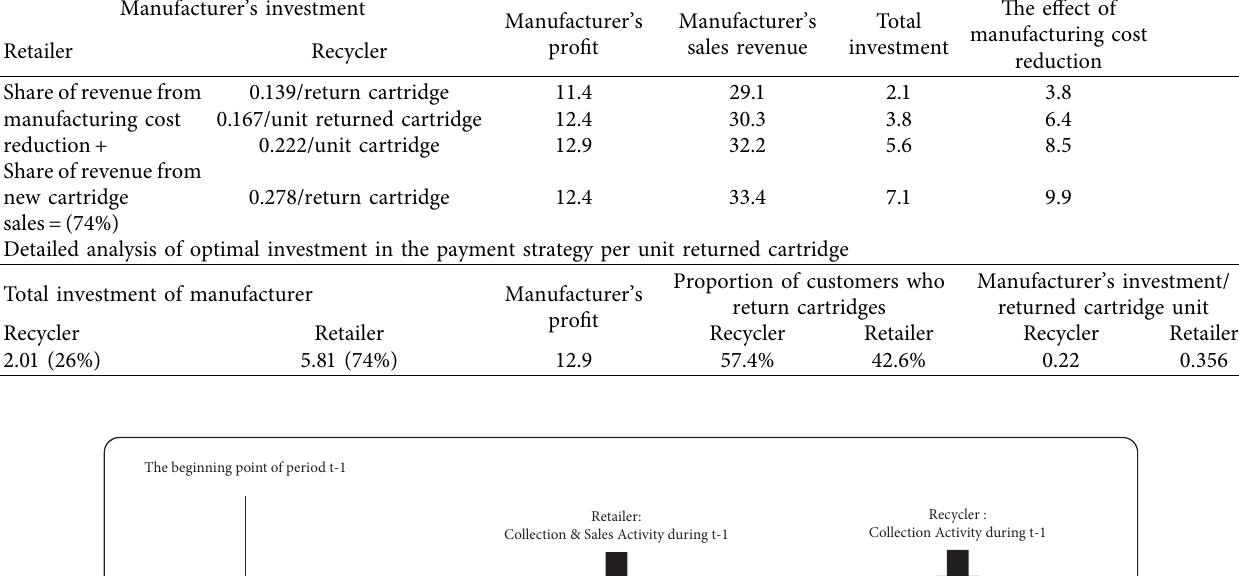
Table 3: Results of the payment strategy per unit returned cartridge ( s � 0.65, k � 0.6).